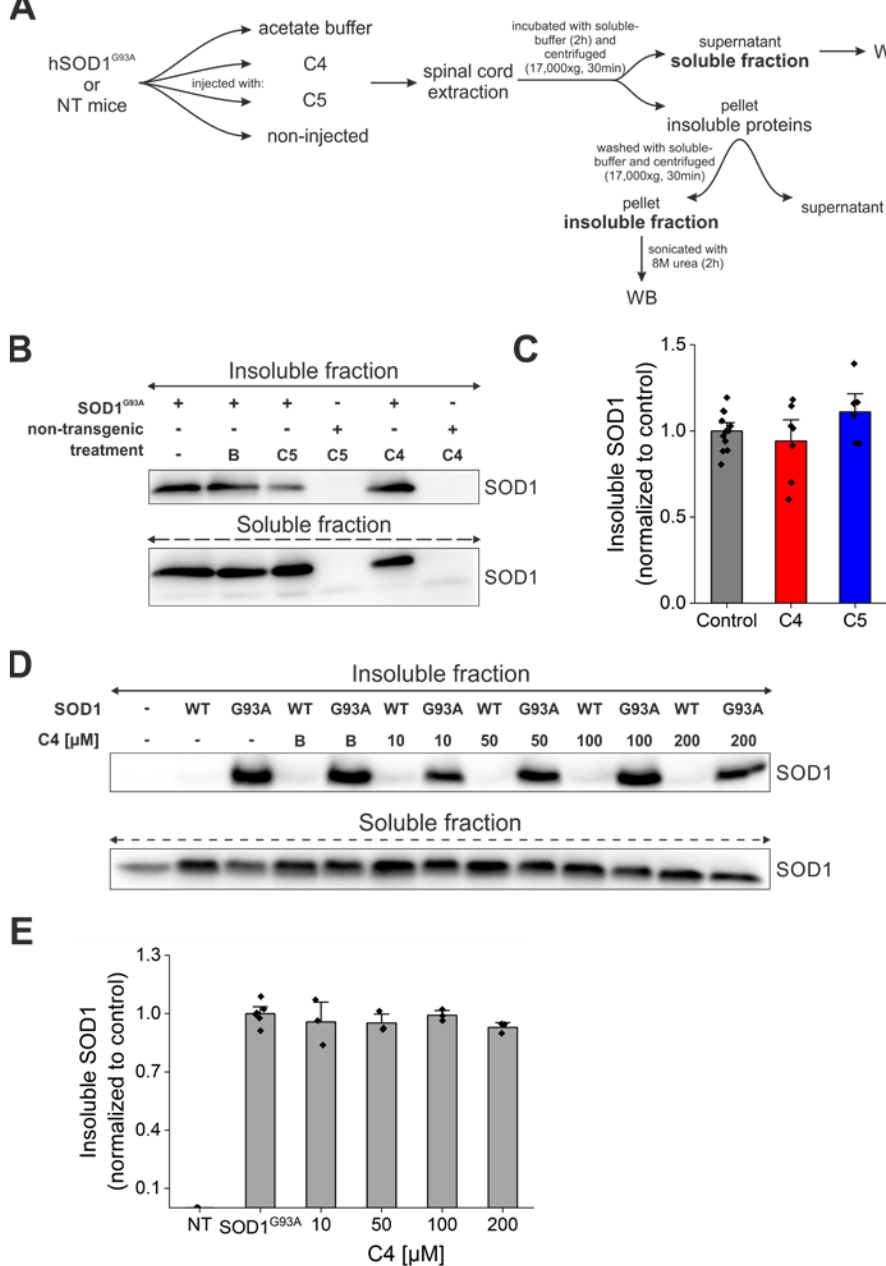
Figure 6. C4 or C5 chemical chaperones did not reduce SOD1 aggregate formation in vivo. ( A ) A schematic representation of the experimental protocol. ( B ) SOD1 aggregation levels were detected by immunoblotting of soluble and SDS-insoluble fractions of spinal cords from untreated and C4- or C5-treated mutant SOD1 G93A mice. Anti-GAPDH antibody was used to detect total protein loading amounts. Data indicate one membrane out of 3 independent experiments. ( C ) Quantification of the band intensity representing the insoluble SOD1 in fractions of spinal cords from untreated ( n = 12, grey) and C4 ( n = 7, red) or C5 ( n = 6, blue) treated mutant SOD1 G93A mice performed with Evolution-Capt Edge software. ( D , E ) SH-SY5Y neuronal cells were transfected with hSOD1 WT or hSOD1 G93A plasmids and treated with different concentrations of C4 (10–200 µM). ( D ) SOD1 aggregation levels were detected by immunoblotting of insoluble fractions of the cell lysates. ( E ) Quantification of bands intensity of SOD1 insoluble to total SOD1 amount (soluble + insoluble). NT—non-transfected. Quantification analysis of the relative aggregation propensity performed with student t-test. Bars represent mean ± SEM.